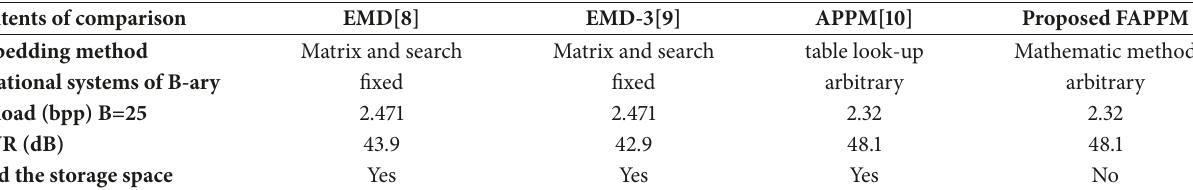
Table 2: Comparison of results.